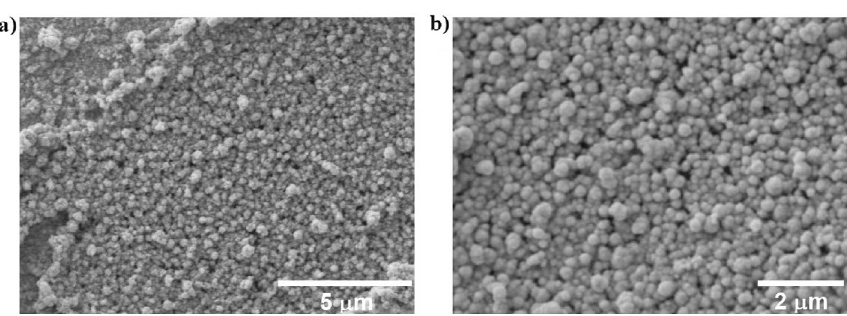
Figure 3. Scanning electron microscopy images of ALG-thiomer/Pt brush at 10 kV and ( a ) 10,000, and ( b ) 16,100 times magnification, respectively, showing a uniform brush formation and deposition over the electrode surface with terminal nodes ranging between 80 to 400 nm in